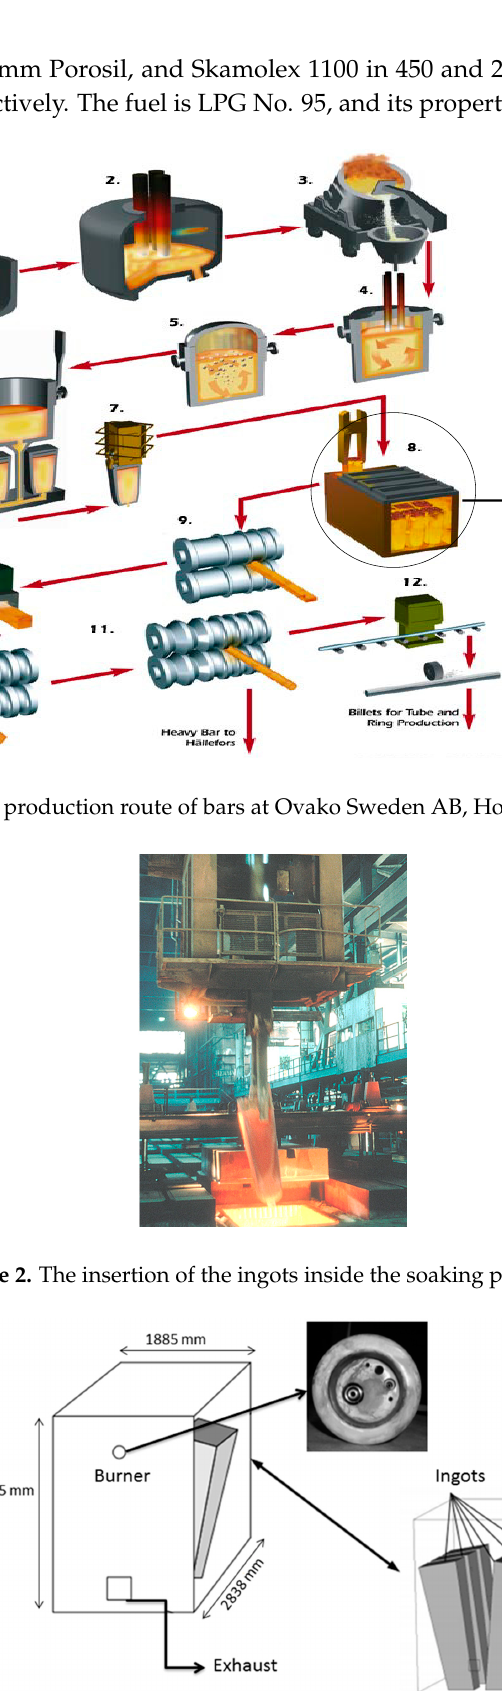
Figure 3. Soaking pit furnace configuration and arrangement of ingots inside the furnace [26].